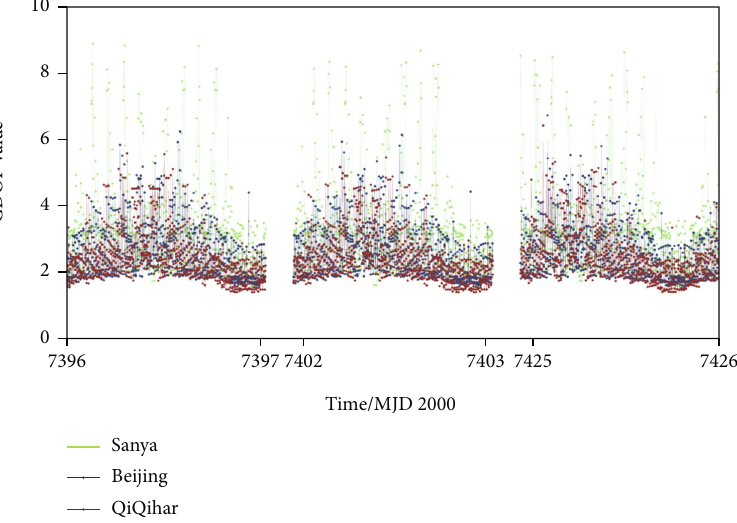
Figure 13: Navigation performance for three typical cities of the 70-satellite Walker